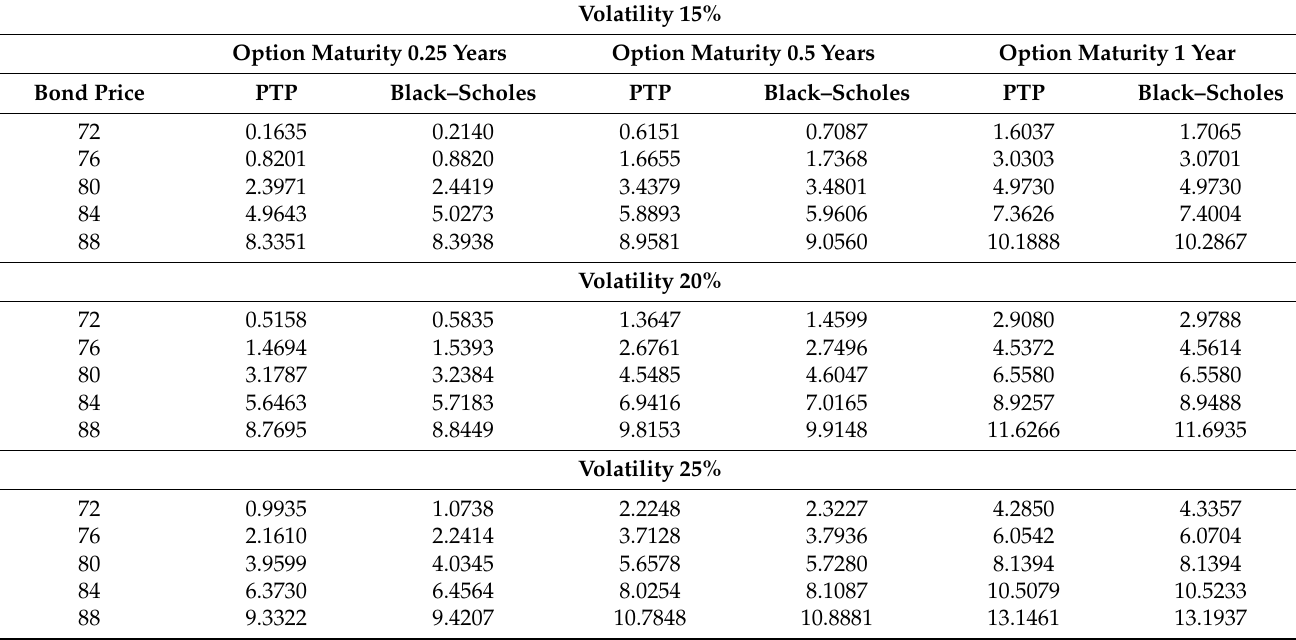
Table 1. Comparison of PTP values to Black–Scholes: strike price 80, risk-free rate 0.5%, bond maturity 20